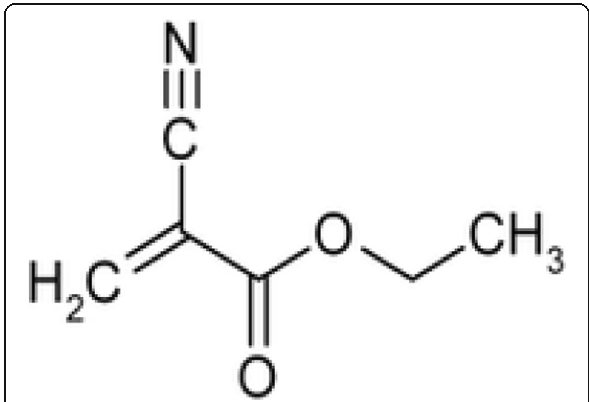
Fig. 1 Chemical structure of Ethyl Cyanoacrylate